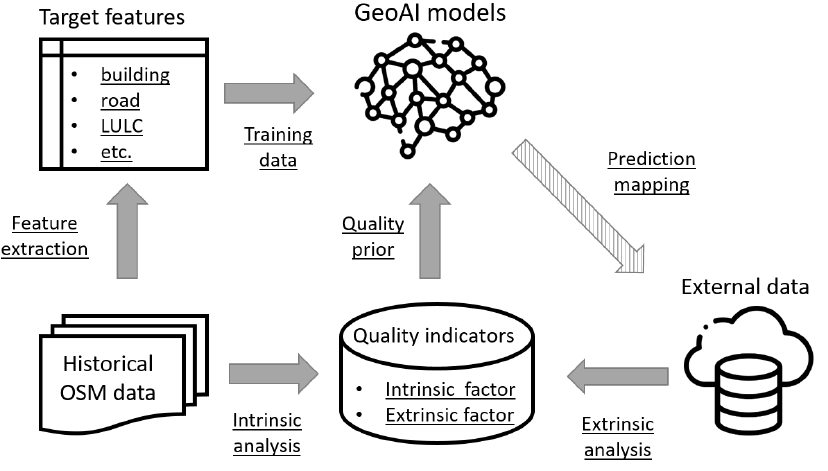
Figure 2. The conceptual model of converting OSM contribution to quality-aware training data of GeoAI models.